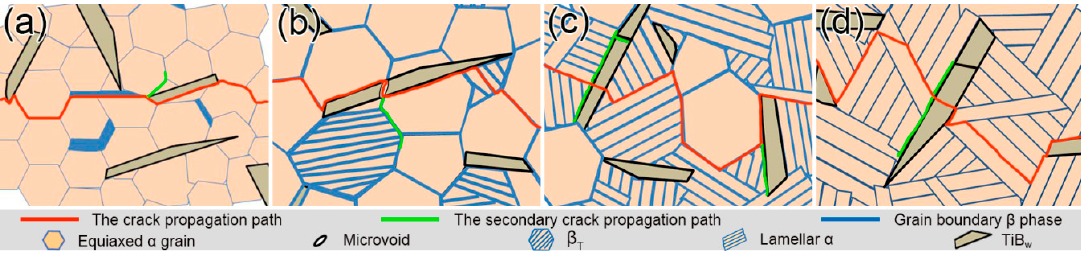
Figure 9. The schematic diagrams of the crack propagation paths in different microstructure features: ( a ) as-forged; ( b ) HT1; ( c ) HT2; and ( d ) HT3.